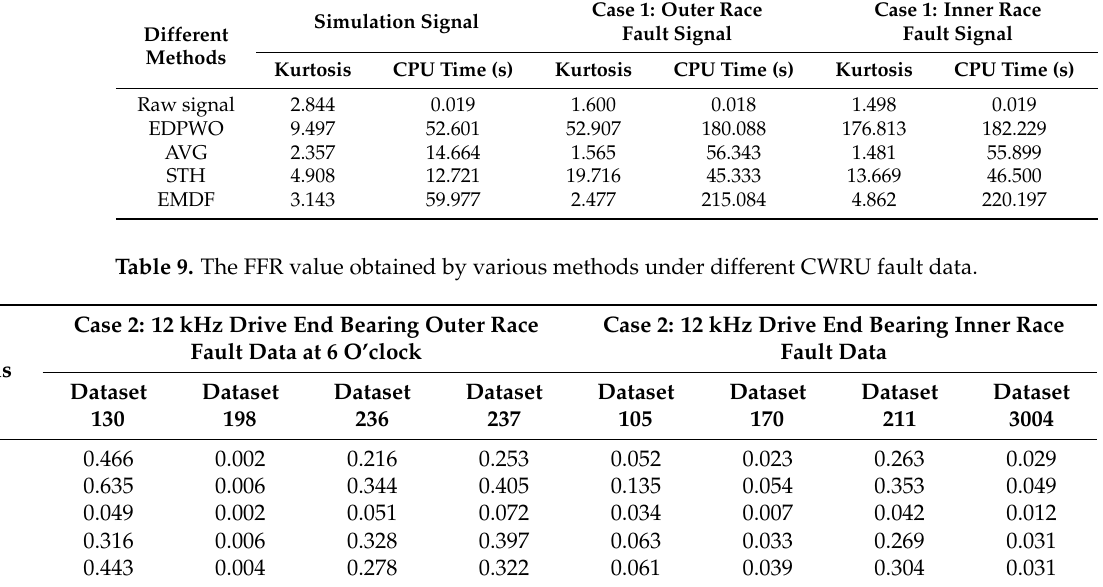
Table 10. The kurtosis value obtained by various methods under different CWRU fault data.